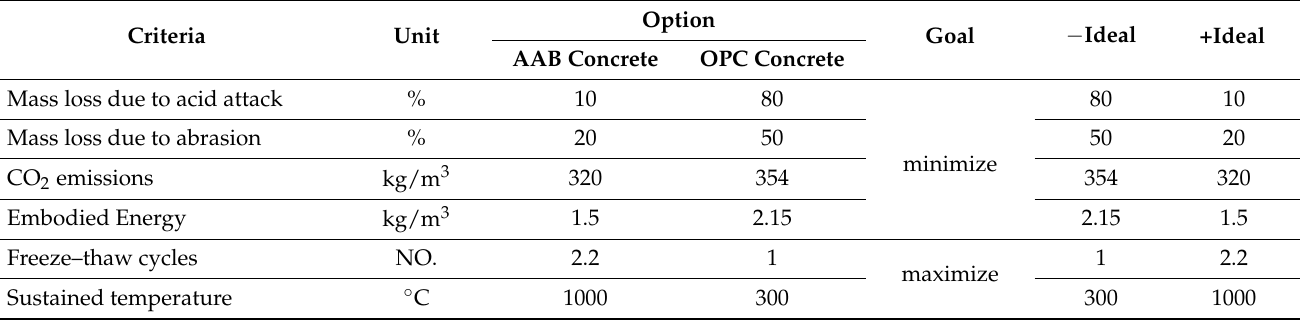
Table 8. Selection of best alternative based on TOPSIS